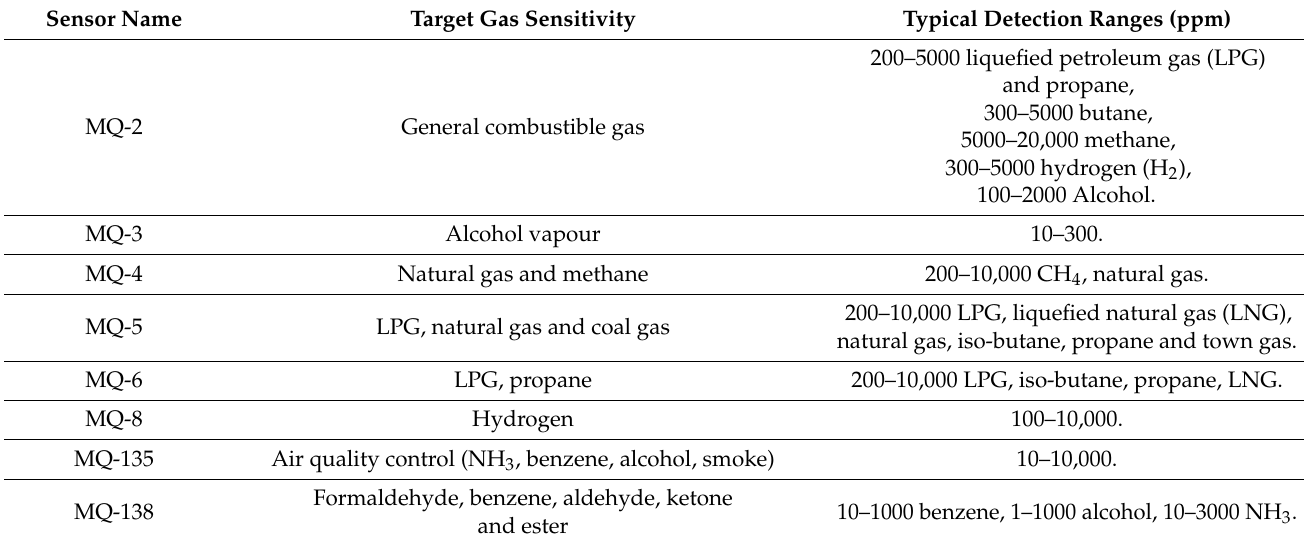
Table 1. Application of metal-oxide semiconductors (MOS) sensors, target gas sensitivity, and typical detection ranges according to the